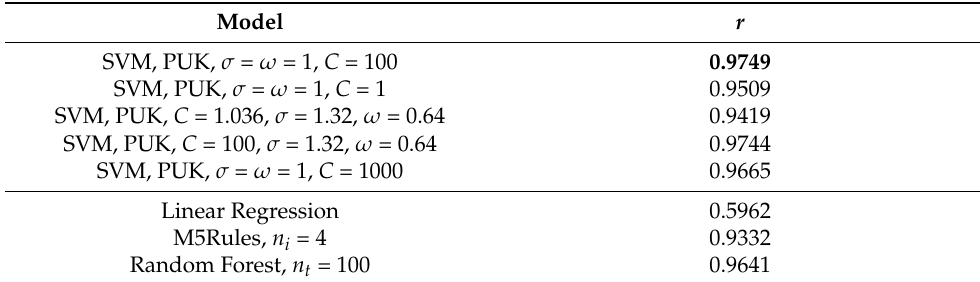
Table 3. Cross-validation results for turbidity